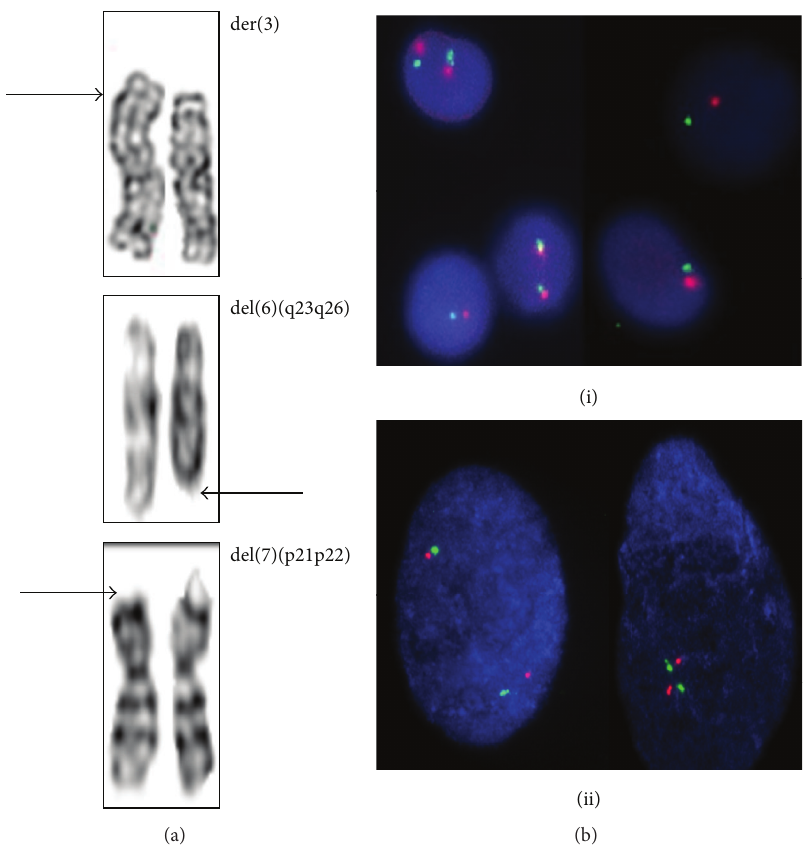
Figure 4: Cytogenetic findings of MDS derived MSCs. (a) Chromosomal abnormalities of MDS-MSCs. Distinct chromosomal abnormalities were found in three patients: 46,XX,der(3) in 14-020, 46,XY,del(6)(q23q26) in 14-072, and 38 ∼ 43,XY,del(7)(p21p22) in 14-080. (b) FISH analysis of bone marrow (i) and MSCs (ii) of del(5q) patient (14-081). Bone marrow contained two clones; the normal cells showed two red and two green signals and the cells in the abnormal clone showed one red and one green signal. MSCs of this patient showed two red and two green signals indicating the absence of